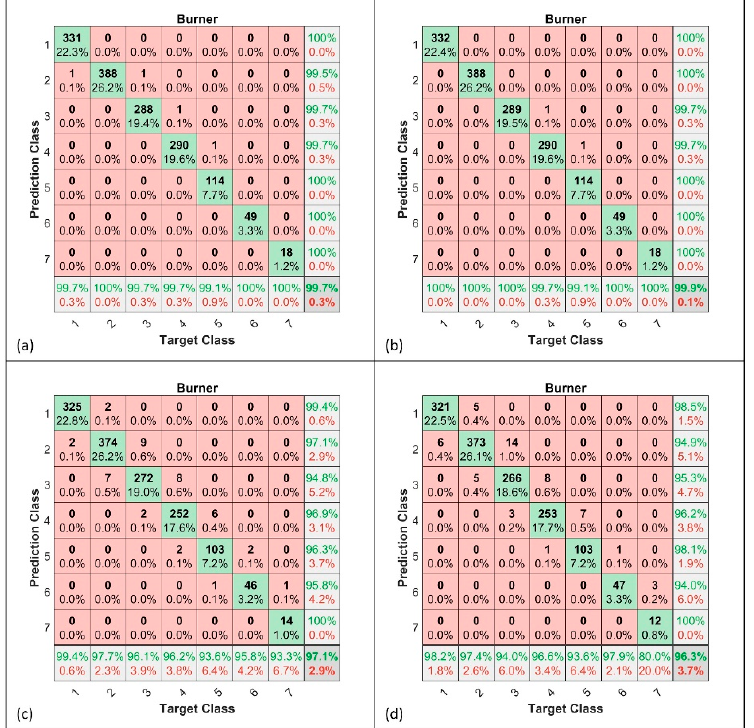
Figure 14. Confusion matrix for burner. ( a ): Single-component FFNN; ( b ): single-component KPCA + FFNN; ( c ): multi-component FFNN; ( d ): multi-component KPCA + FFNN.